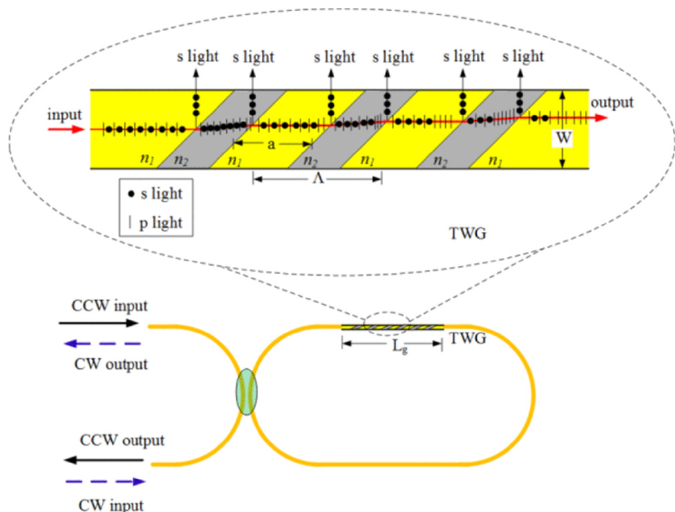
Figure 15. The WRR with a 45° tilted waveguide grating. Reprinted with permission from ref. [46]. Copyright 2015